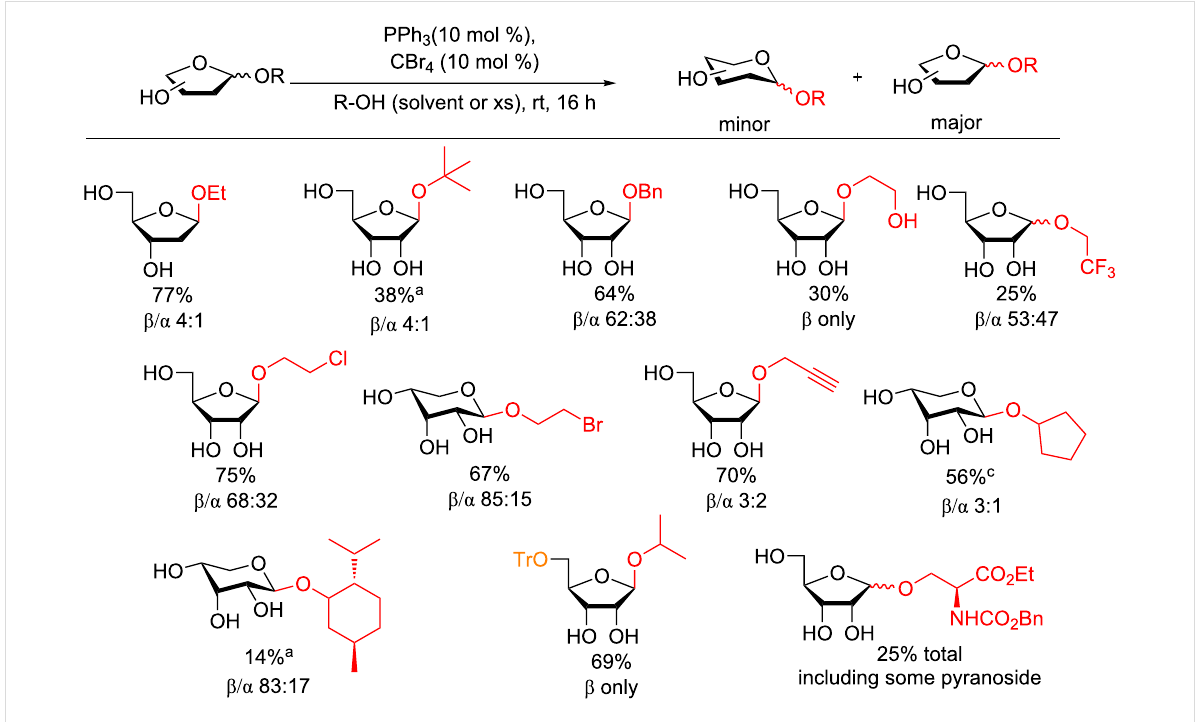
Figure 15: Access to ribofuranosyl glycosides as the major product under catalytic conditions. a LiOCl 4 (2.0 equiv.) was used to bolster the yield.